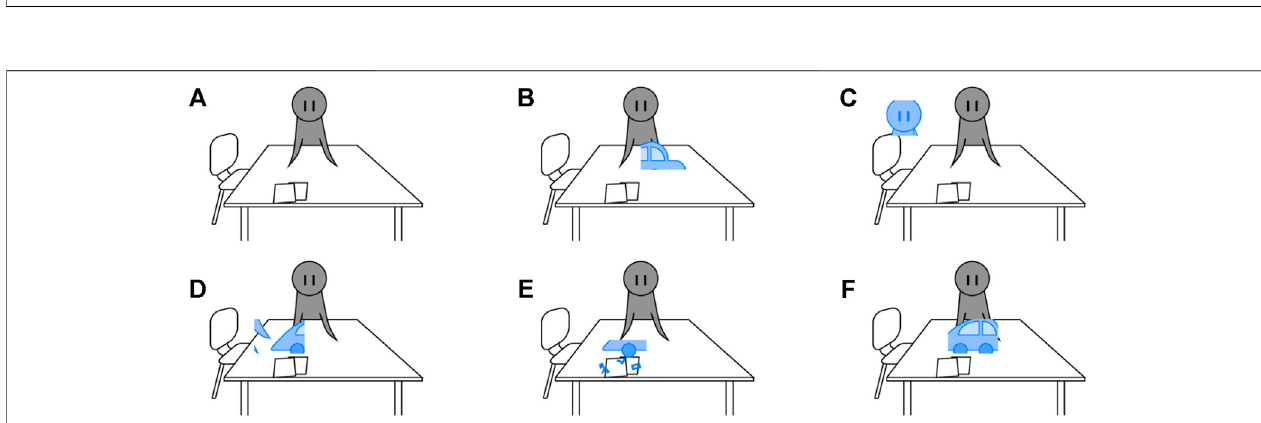
FIGURE 2 | Illustrations of a user ’ s view when using an AR headset with limited FOV. Virtual content is shown in blue. In this fi gure, there is no rectangle indicating thevirtual fi eldofviewinordertomoreaccuratelyshowtheuser ’ sviewofthescene. (A) Theuserismakingeyecontactwithaphysicallyco-locatedcollaborator. (B) The userlookstopartofthevirtualcarmodelthatthecollaboratorisspeakingabout.Thewholemodeldoesnot fi tintoview,soonlypartisvisible. (C) Theuserlooksoverata remote collaborator. The virtual car is no longer visible. (D) The user looks down at the part of the car the remote collaborator is gesturing towards. The collaborator ’ sfaceisnolongervisible. (E) Theuserchecksnotes,showingpartofthevirtualcarabovethevirtualannotatesmadeonthepapernotes. (F) Theusertriesto view the entire car, but it does not fi t within the headset ’ s FOV. To see the entire scene at once, see Figure 1 panel B.